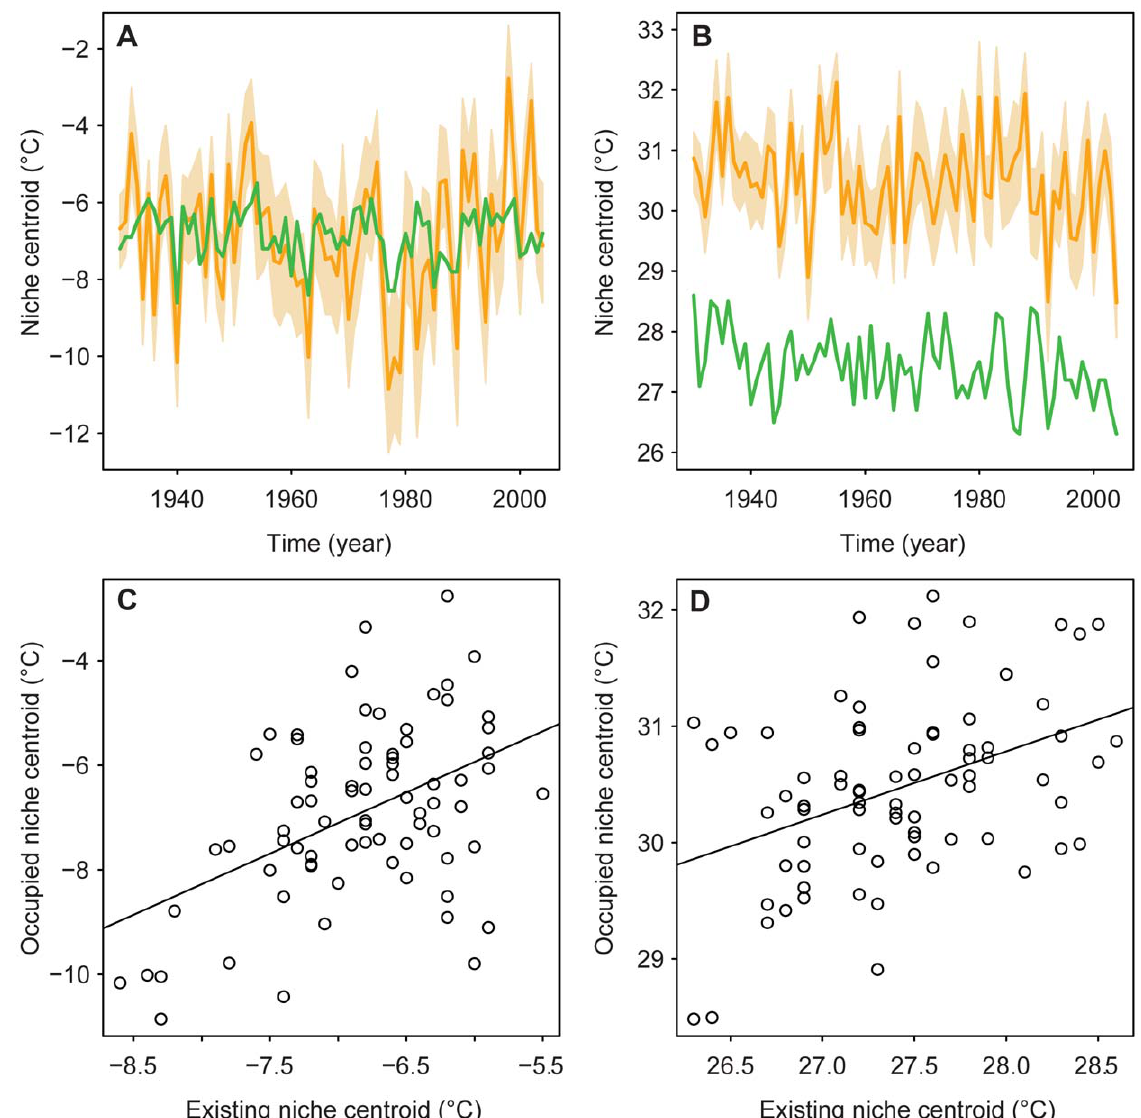
Figure 2. Time series of the occupied and existing LD50 niche centroid locations in climate space: (A) minimum temperature of the coldest month; and (B) maximum temperature of the warmest month. Light orange polygons show the 95% confidence intervals, and dark orange lines the means, of occupied niche centroids evaluated for 100 bootstrap samples (controlling for sample size over time, see Materials and Methods). Green lines show the existing LD50 niche centroids. Plots of the annual location of the occupied niche centroid versus the existing LD50 niche centroid, 1930–2004, for: (C) minimum temperature of the coldest month; and (D) maximum temperature of the warmest month. Solid lines show slope of observed Pearson’s